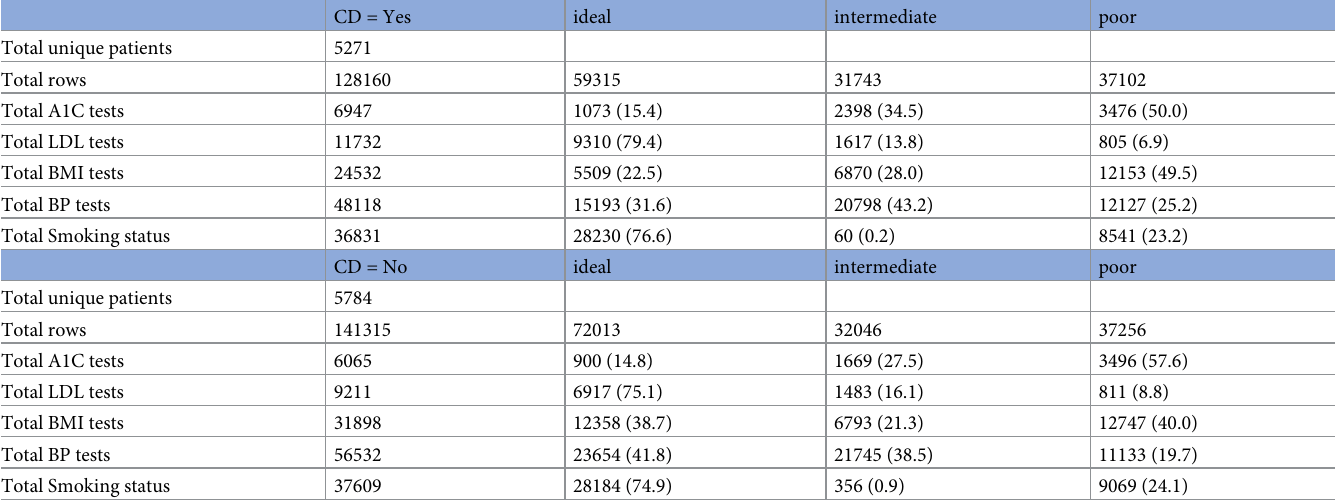
Table 3. Characteristics [mean, (SD) or n (%)] of the converted